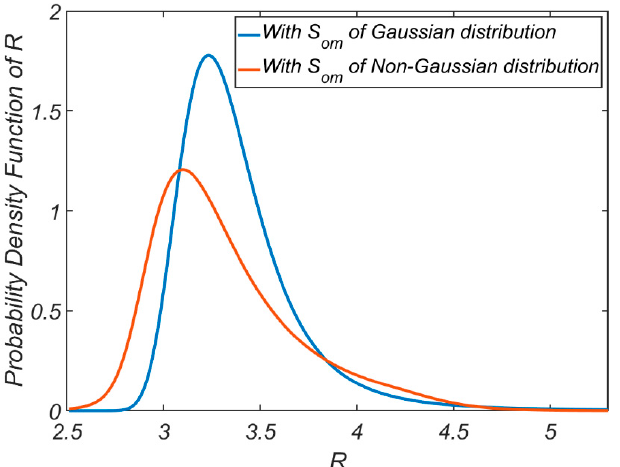
Table 3. List of most probable armor block strength for varying bandwidth of wave spectrum.